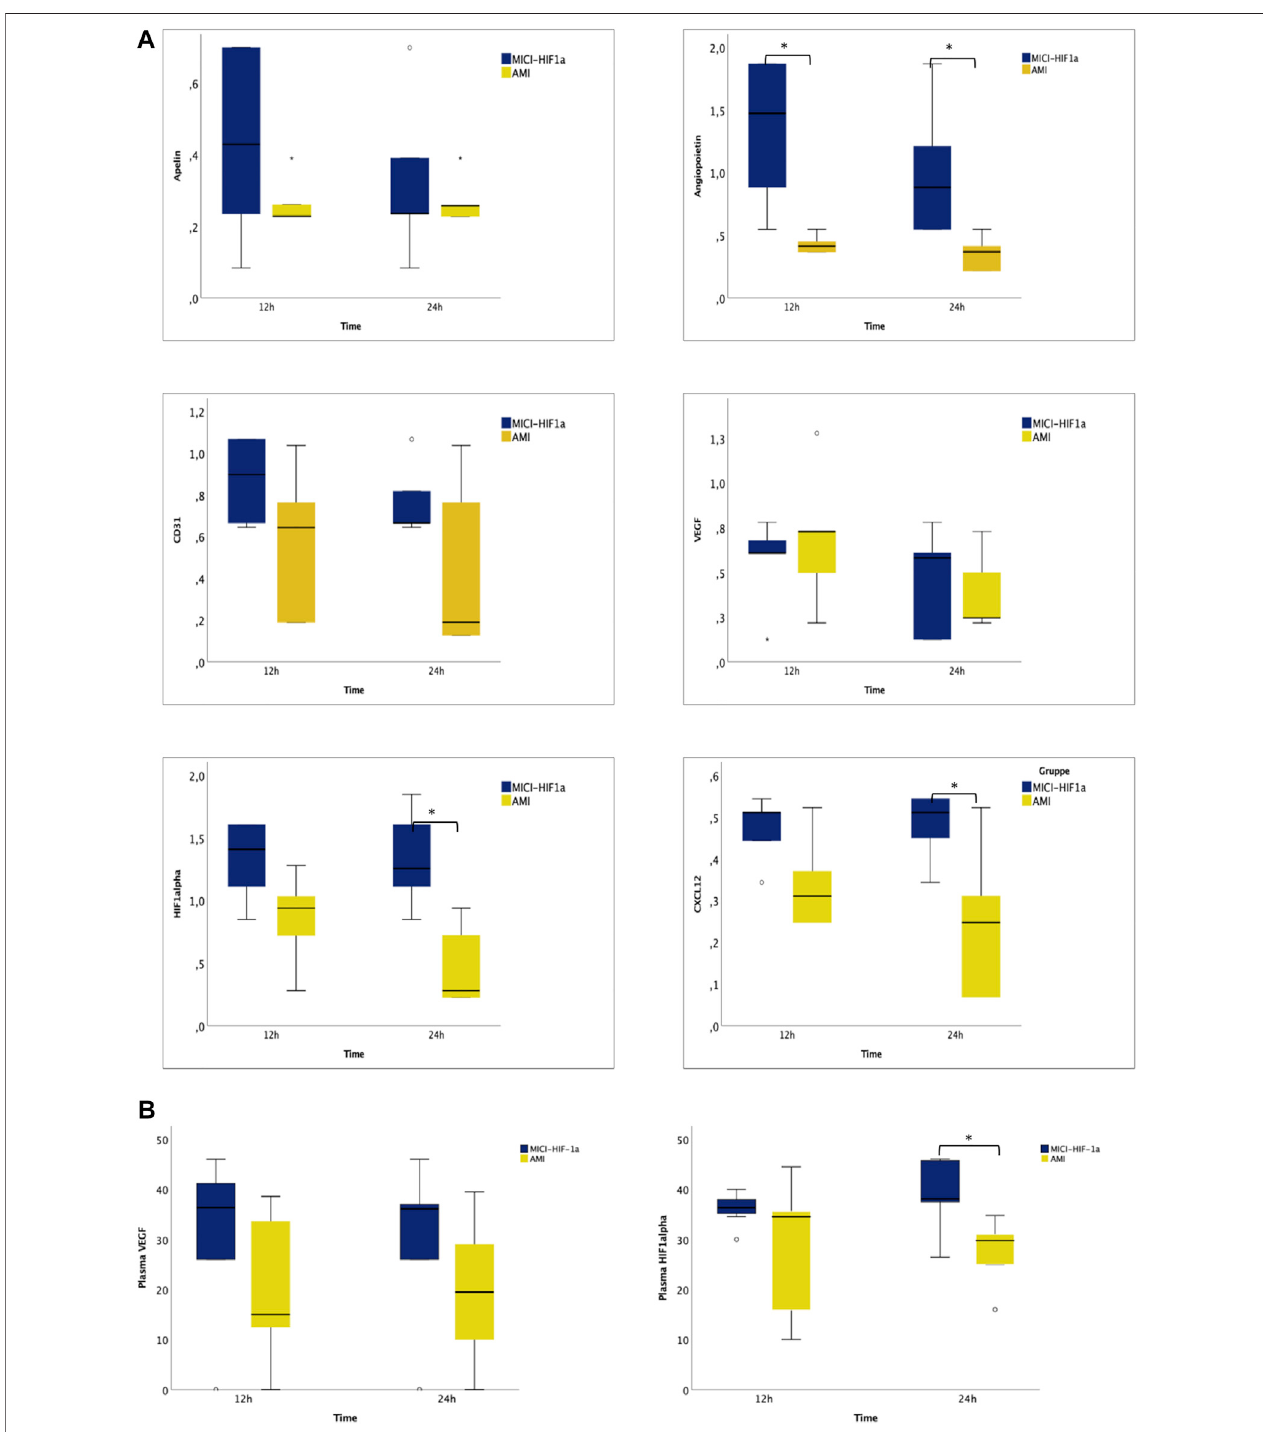
FIGURE 4 | Myocardial expression of angiogenesis and remodeling related genes, and circulating RNAs in plasma 12 and 24 h after intramyocardial injection of porcine MSC transfected with MiCi-HIF1 α into the border area of chronic infarction, compared to non-treated infarcted heart. (A) mRNA expression levels of apelin, angiopoietin, CD31, VEGF, HIF-1 a, and CXCL12 in pMSC-MICI-HIF-1 α treated and untreated myocardium, 12 and 24 h after injection of pMSC-MiCi-HIF1 α , data are represented relative to healthy non-infarcted controls (relative expression 1.0 for each) with normalization to the reference gene ß -actin. n = 5. FU: follow up. Statistics:t-test, *: p < 0.05. (B) Circulating mRNA levels ofVEGF and HIF-1 a inpMSC-MICI-HIF-1 α treatedand untreated animals,12and 24 h after injection ofpMSC- MiCi-HIF1 α . Data are represented as relative expression. n = 5. *: p < 0.05.